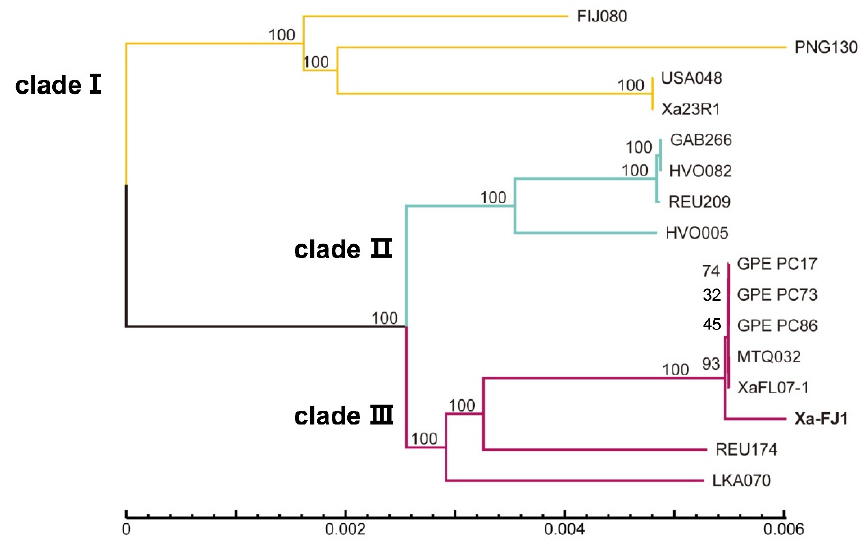
Figure 3. Neighbor-joining phylogenetic tree of X. albilineans constructed with the core-genome sequence of 16 strains of X. albilineans using TreeBesT software. Bootstrap values based on 1000 replications are indicated at branches. Scale bar units are in number of substitutions per nucleotide.